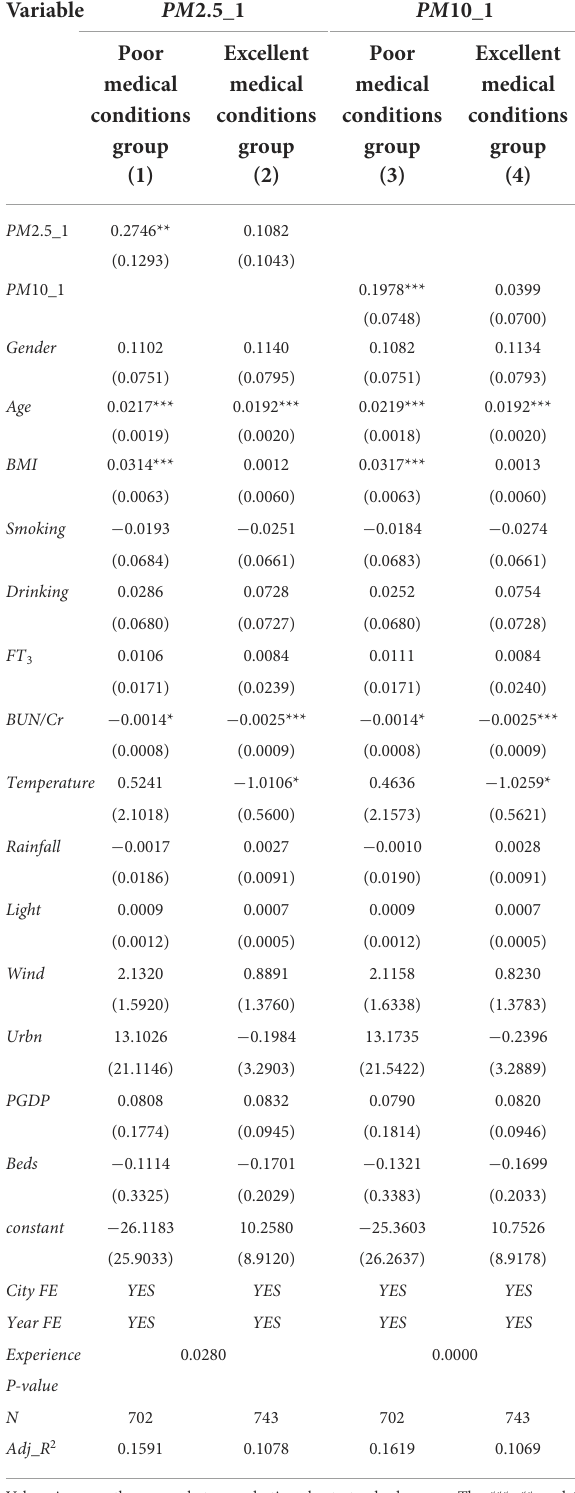
TABLE 8 Heterogeneity analysis of medical and health